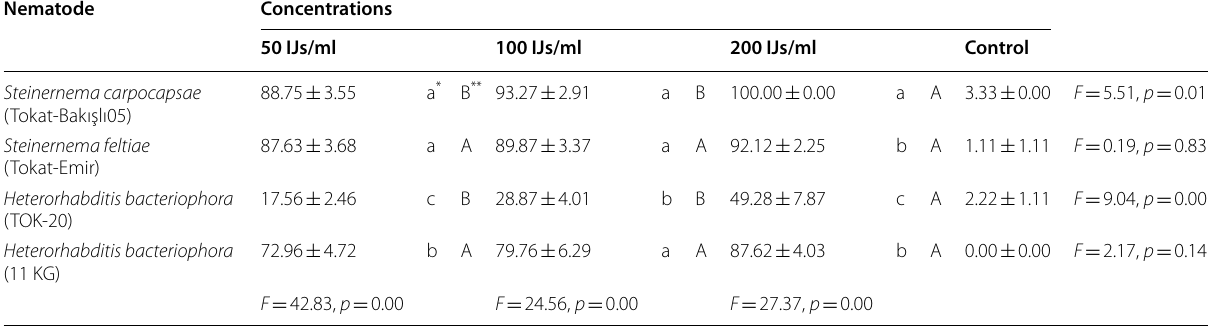
* Means within column bearing the same letter are not significantly different (Duncan’s test, p > 0.05) ** Means within lines bearing the same letter are not significantly different (Duncan’s test, p > 0.05)